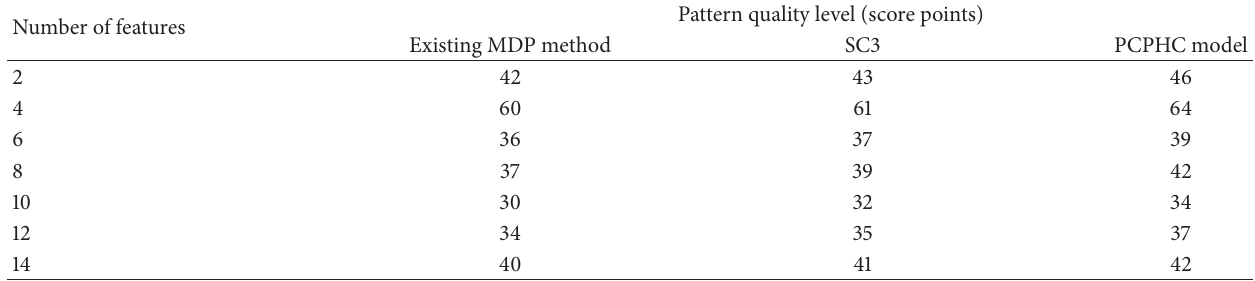
Table 3: Tabulation of pattern quality level.